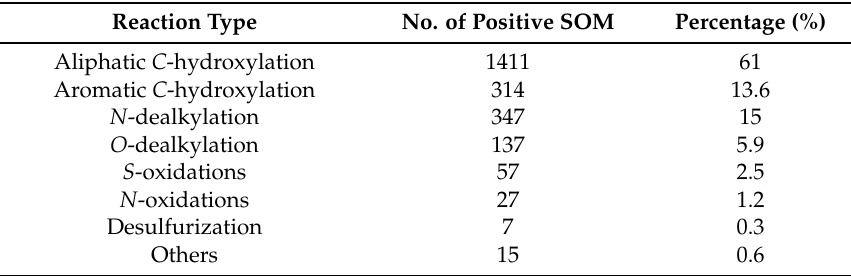
Table 3. Description of the datasets collected from the literature.